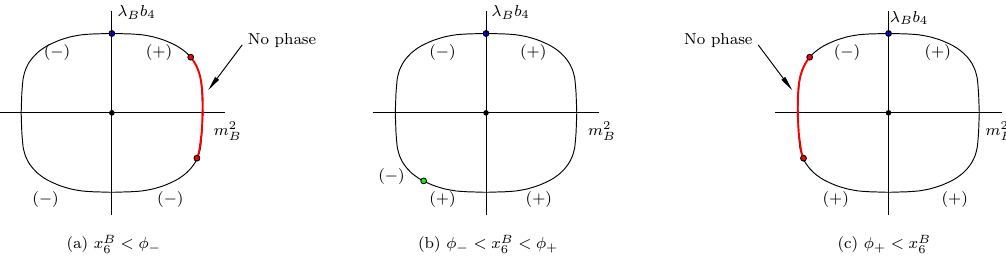
Figure 27. The phase diagram of the regular boson theory. The unHiggsed phase is labelled by (+) and the Higgsed phase is labelled by ( (cid:0) ). The blue dot on the positive (cid:21) B b 4 axis corresponds to a second order phase transition governed by the CB conformal theory. The red regions in (cid:12)gures (a) and (c) are regions where there e is no phase and the potential is monotonic. The green dot in (cid:12)gure (b) is a (cid:12)rst order phase